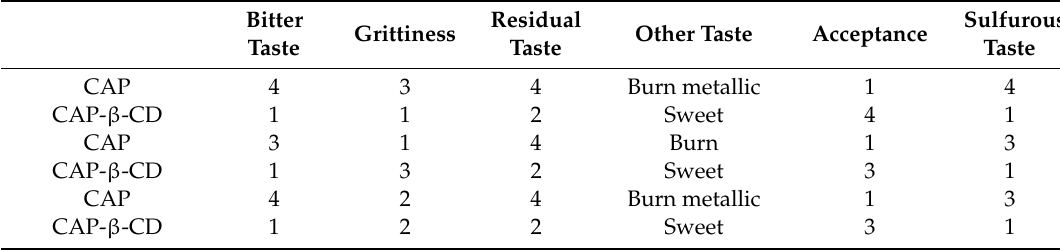
Table 3. Evaluation by subjects of the taste for the tablets containing CAP and CAP- β